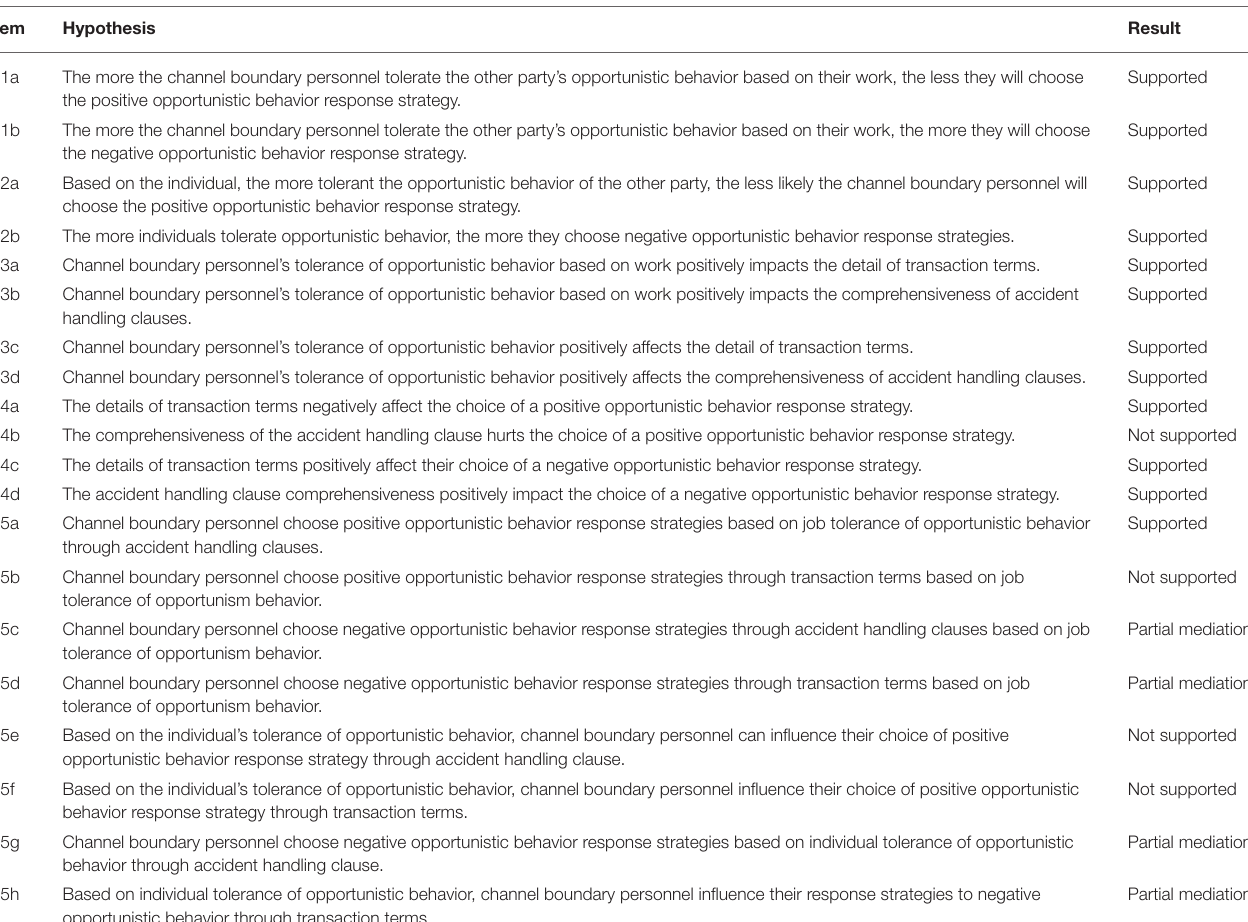
TABLE 6 | Summary of hypothesis